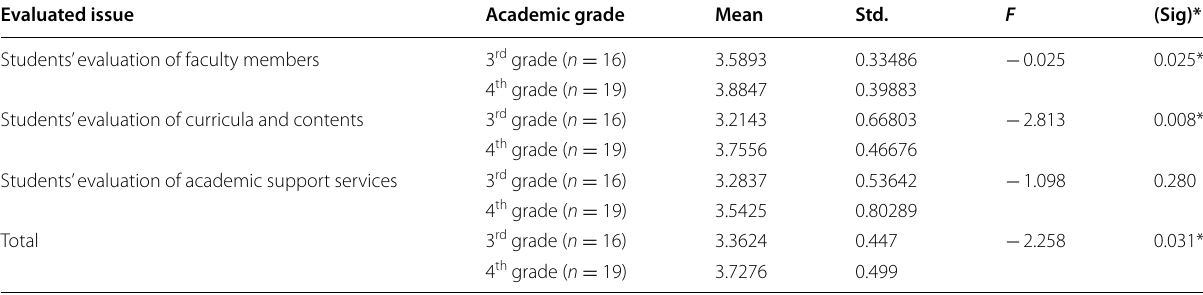
Table 4 Means, standard deviations, and one-way ANOVA analysis of students’ evaluation of the FS program at the Al-Istiqlal